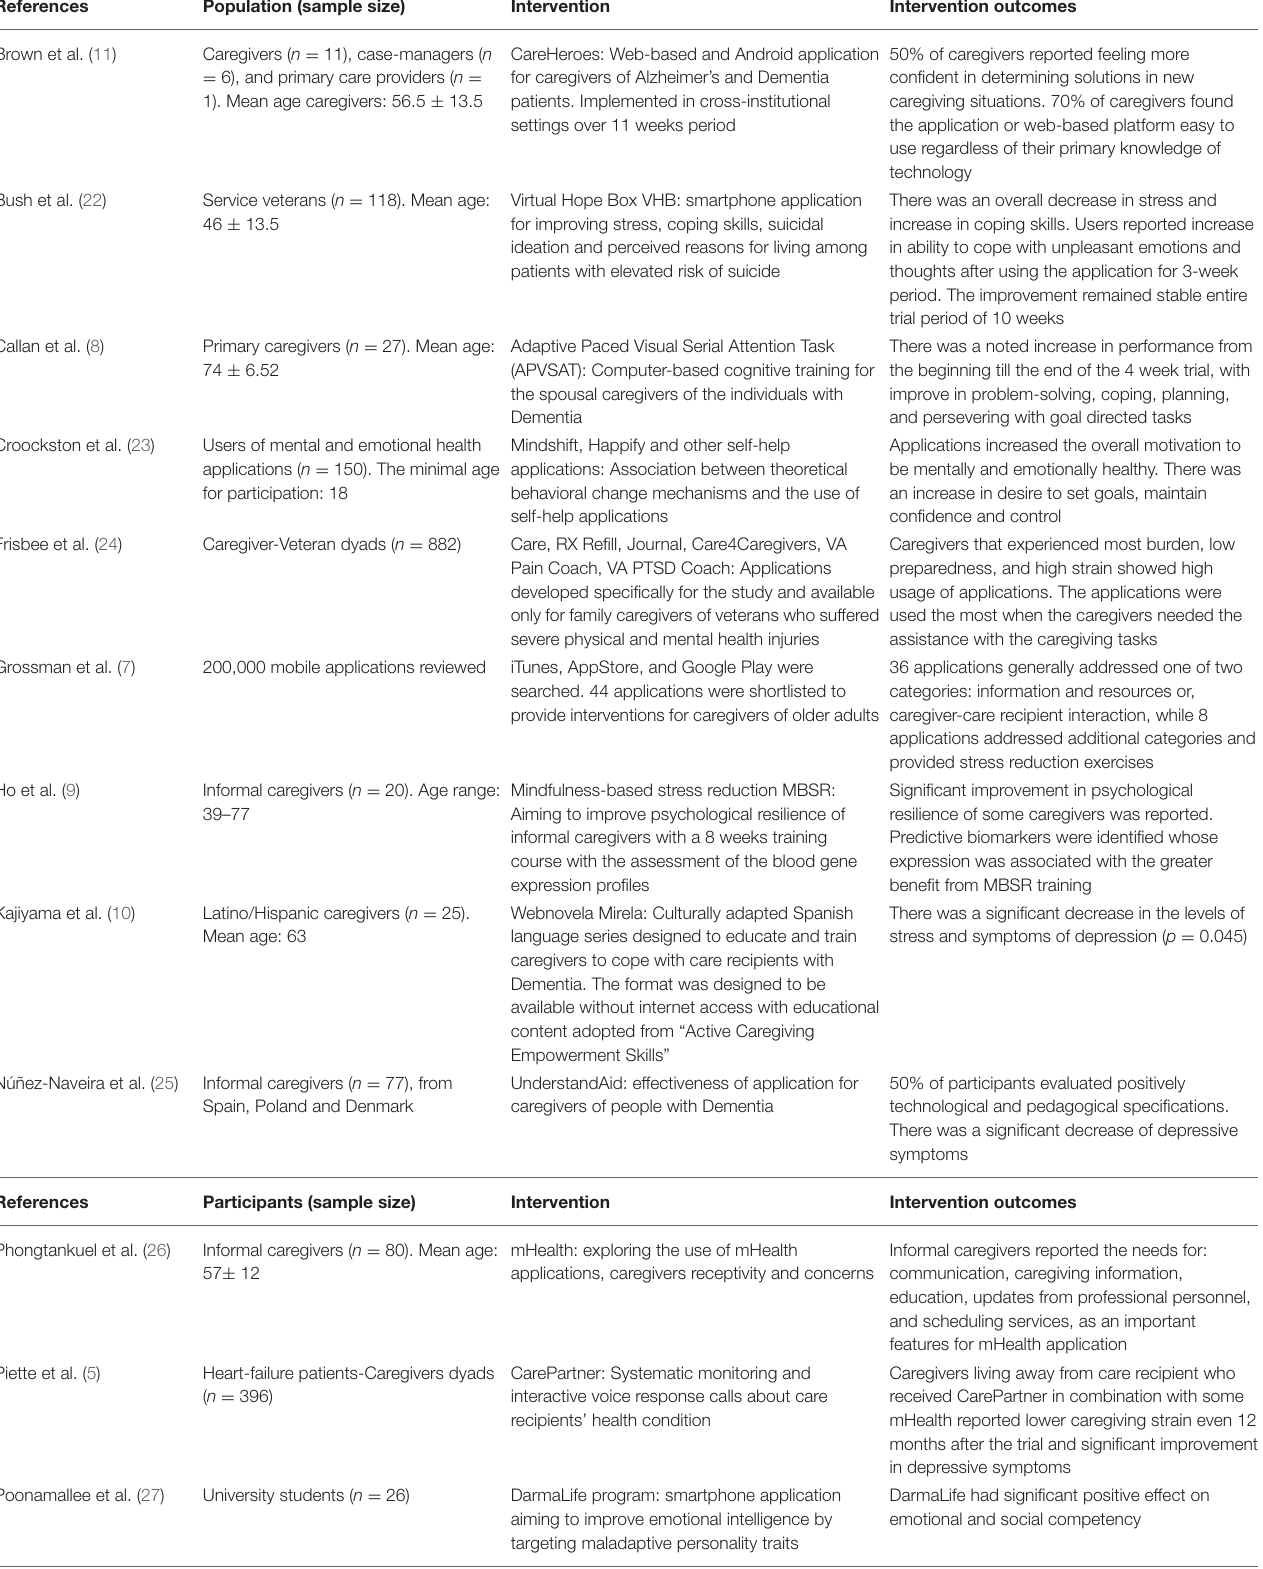
TABLE 1 | Summary table of studies included in the present scoping